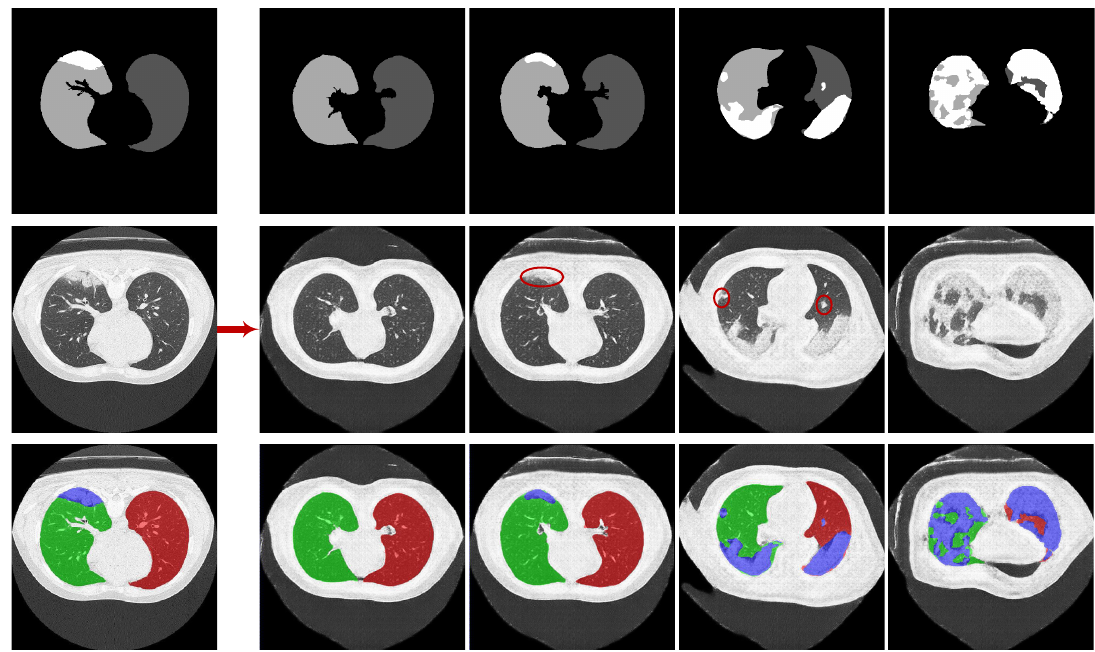
Figure 4. The synthetic radiological images from CoSinGAN trained with given axial CT slice and annotation mask of the lungs and COVID-19 infection. The first row denotes the conditional masks, where the white and gray (e.g., light gray and dark gray) represent the infected regions and lungs, respectively. The last row denotes synthetic CT slices with input condition overlays, where the blue denotes infected regions and the red (or green) represents the lungs.